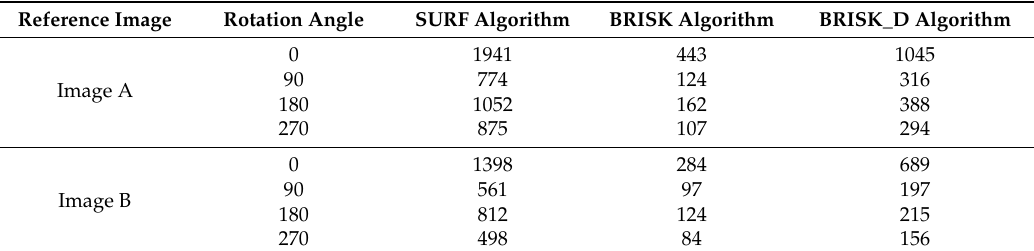
Table 4. The correct matching number of reference image after rotating.